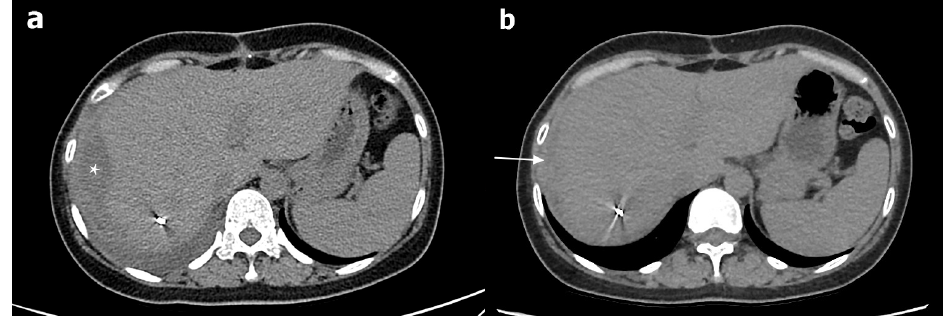
Figure 3. ( a ) Computed tomography (CT) performed four weeks after the TAE reveals the early organization of a subcapsular hepatic hematoma (asterisk). ( b ) CT performed six weeks after the TAE reveals the near-complete resolution of the preexisting subcapsular hematoma (arrow).